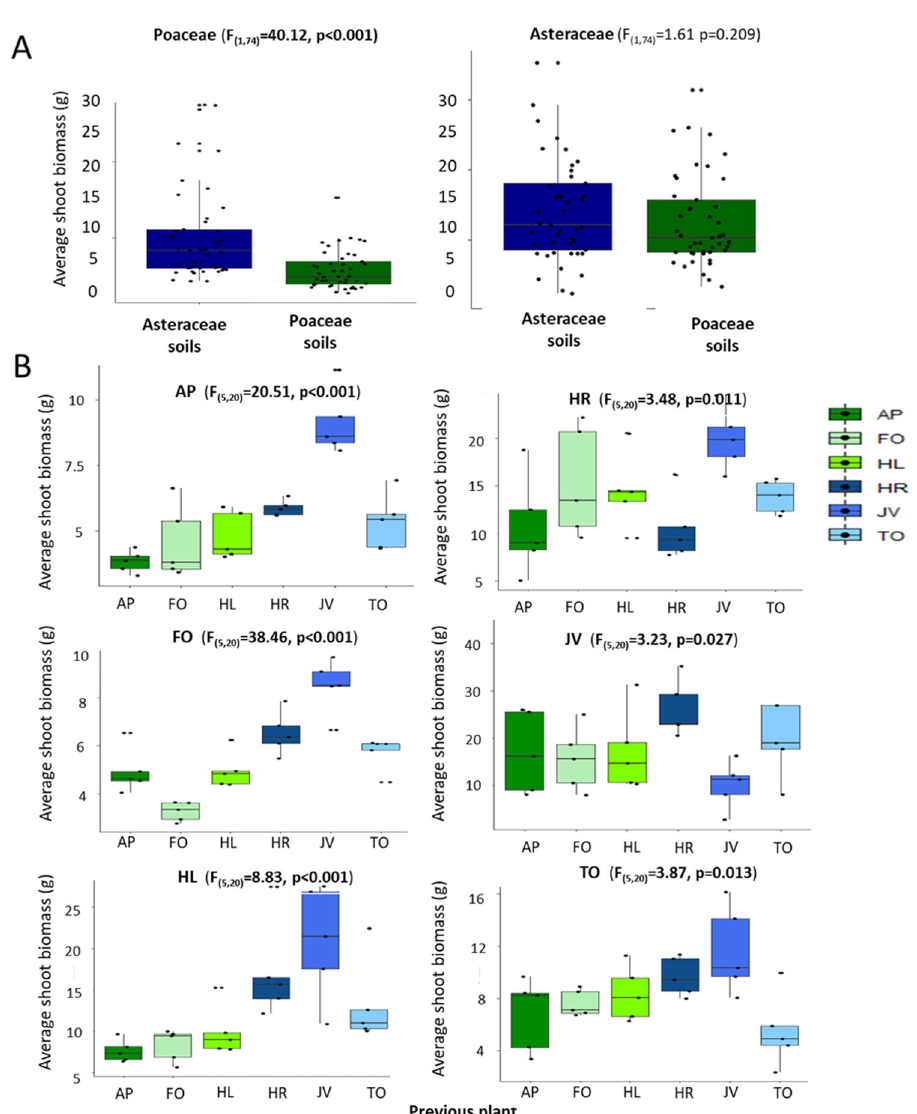
Fig. 4 Plant growth across soils. Plant growth in the feedback phase affected by the previous plant and explained by soil microbial communities. Average shoot biomass (dw) of the responding Poaceae and Asteraceae grown in Poaceae and Asteraceae soils ( A ) and of individual plants grown in all the possible soils ( B ). The Tukey box-and-whisker-plots depict median shoot biomass of plants and individual points show the variation between replicate plants ( n = 45 for A and n = 5 for B ). Poaceae are depicted with green colors and Asteraceae with blue. The abbreviations for plant species are AP Alopecurus pratensis , FO Festuca ovina , HL Holcus lanatus , HR Hypochaeris radicata, JV Jacobaea vulgaris , TO Taraxacum of fi cinale . Statistical values are shown above each graph for the full model (lme model shown in Fig.